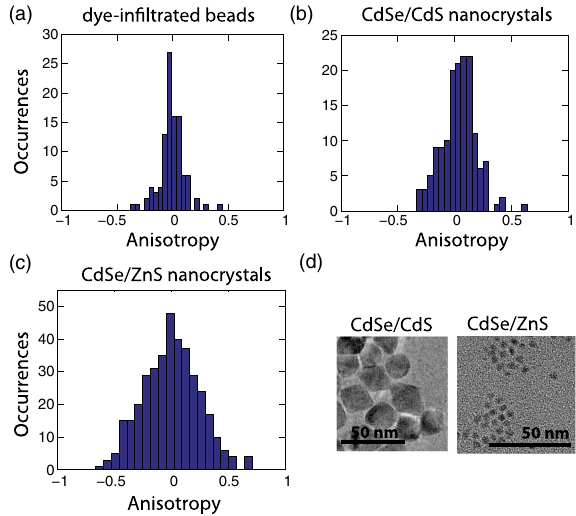
FIG. 4. Distribution of the anisotropy A ¼ ð I x − I y Þ = ð I x þ I y Þ measured for 103 beads (a), 152 CdSe/CdS nanocrystals (b), and 374 CdSe/ZnS nanocrystals (c). Experimental conditions: sit- uation (ii), numerical aperture 1.4, d ¼ 50 nm of PMMA of index 1.5. (d) Transmission electron microscopy image of the CdSe/ CdS and CdSe/ZnS nanocrystal